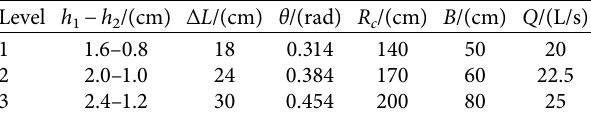
Table 1: Factors and levels of orthogonal test.